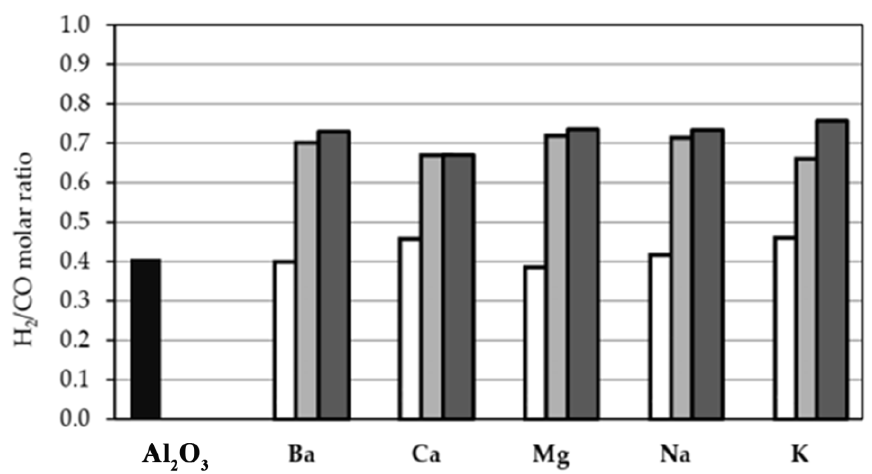
Figure 7. CH 4 conversion, CO 2 conversion, and H 2 /CO molar ratio for Ru/Al 2 O 3 -A/AE(1,5, and 10 wt%) catalysts (750 °C, 135 min reaction time).